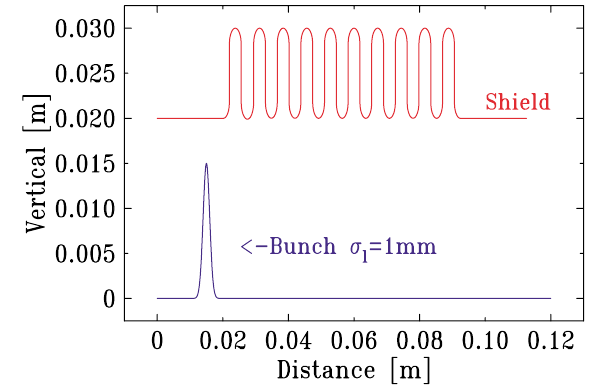
.FIG. 11. (Color) Schematic of the vertical shape of shield for the VUV vacuum bellows and the bunch shape used for wake field